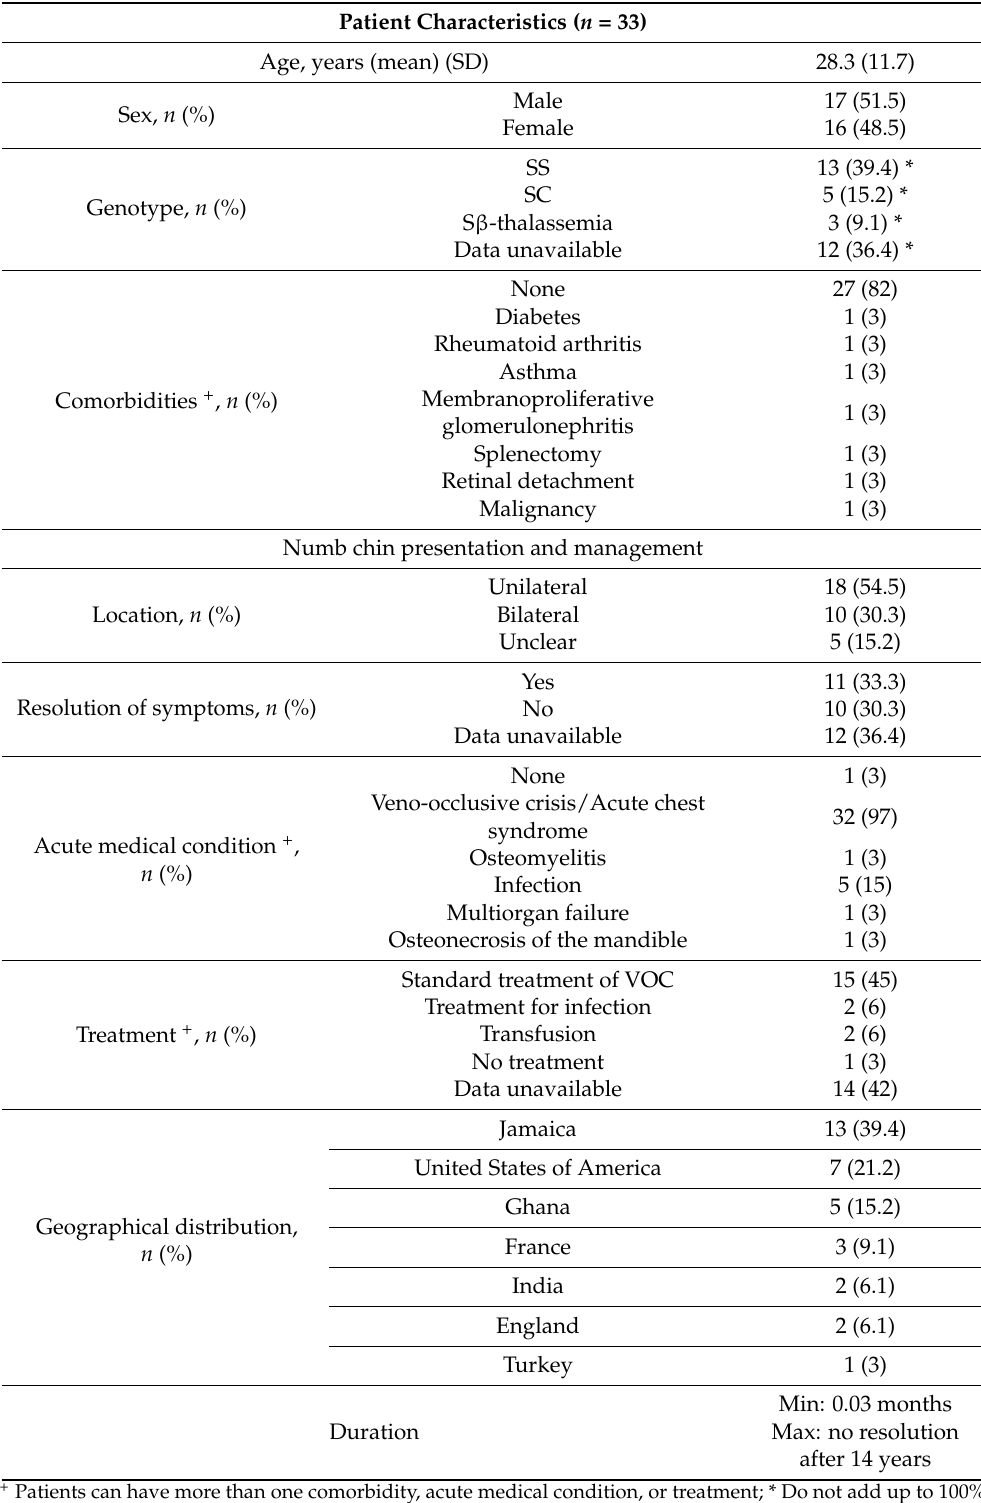
Table 1. Patient characteristics, NCS presentation, and